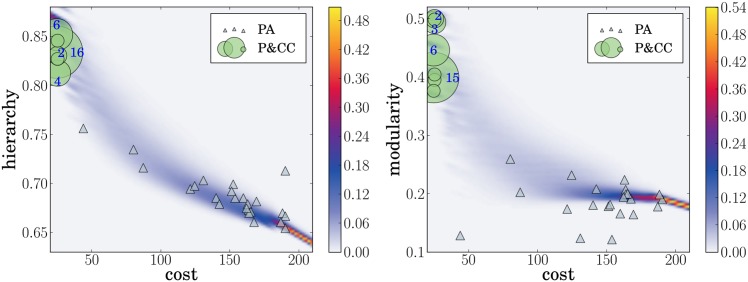
Lower cost networks are more hierarchical and modular.The hierarchy (left) and modularity (right) of randomly generated (i.e. non-functional) networks is shown for each cost after being normalized per cost value and then smoothed by a Gaussian kernel density estimation function. Colors indicate the probability of a network being generated at that location (heat map). Networks evolved in either the P&CC or PA treatment are overlaid as green circles or blue triangles, respectively. Circle or triangle size and the enclosed number indicate the number of networks at that coordinate (no number means 1). All evolved P&CC networks are in the high-hierarchy, low-cost region. Most evolved PA networks are in the high-cost, low-hierarchy region.